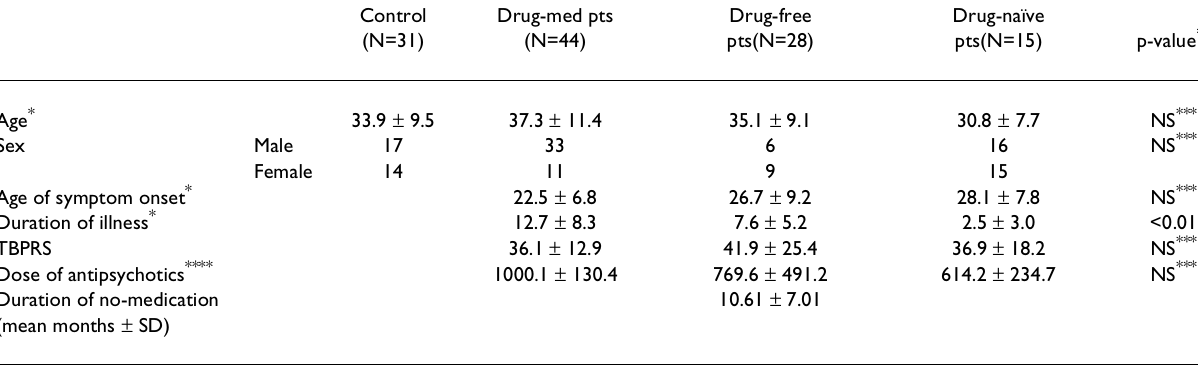
Table 1: Demographic data of study